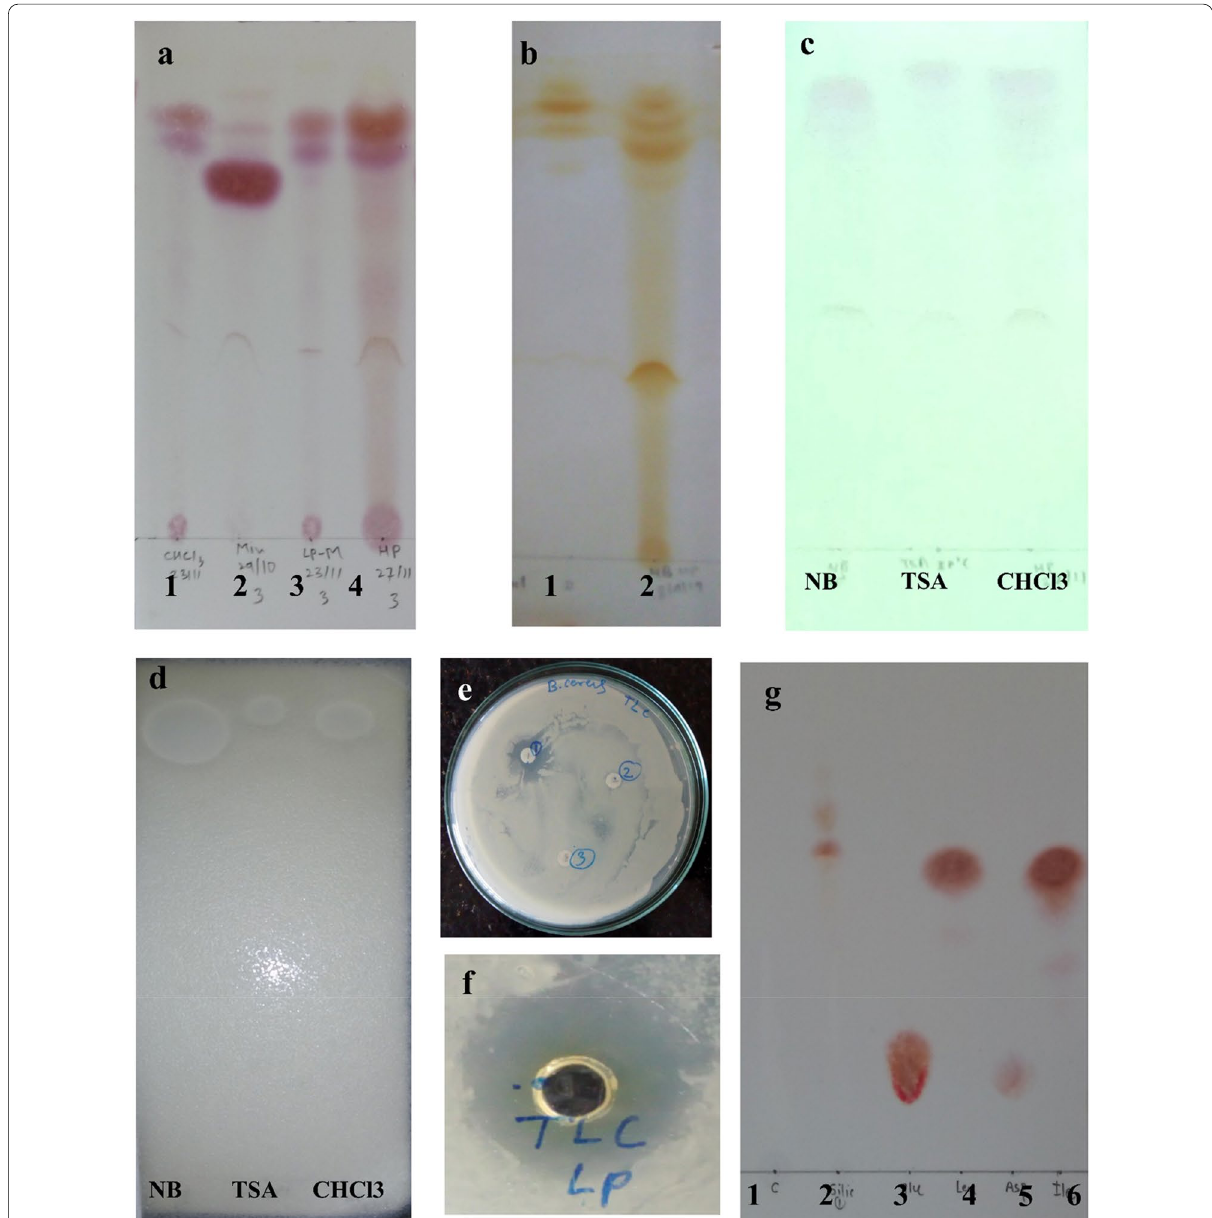
Fig. 5 Thin layer chromatography (TLC) of partial purified lipopeptides from B. velezensis SK using a Solvent system-I and visualized with 0.2% ninhydrin, Lane 1, 2, 3, and 4 correspond to lipopeptide extracted with chloroform, lipopeptides produced in MBM, acid precipitated and methanol extracted lipopeptides and Diaion HP-20 lipopeptides respectively. b Solvent System-II and visualized by iodine vapour, TLC analysis of lipopeptide extracted by HP-20 lane 1 (MBM) and lane 2 (NB). c TLC plates of Diaion HP-20 extracted lipopeptide from NB visualized by UV 254 nm lane1, TSA lane 2, and Chloroform extracted lipopeptides lane 3 using solvent system-II. d In-situ antimicrobial activity of separated lipopeptides against B. cereus NCIM 2703 by using autobiography technique, and e Antimicrobial activity of TLC separated (upper spot) and eluted spots (disk 1) against B. cereus NCIM 2703 by paper disk assay. f Antimicrobial activity of TLC eluted (spot 1) bioactive spot by agar well diffusion assay. g TLC analysis of acid hydrolyzed purified lipopeptide fraction (Lane 2) and intact lipopeptide (Lane 1) as compared to amino acids Glutamate, Leucine, Aspartate and isoleucine lane 3, 4, 5, and 6 respectively after visualization by ninhydrin using solvent